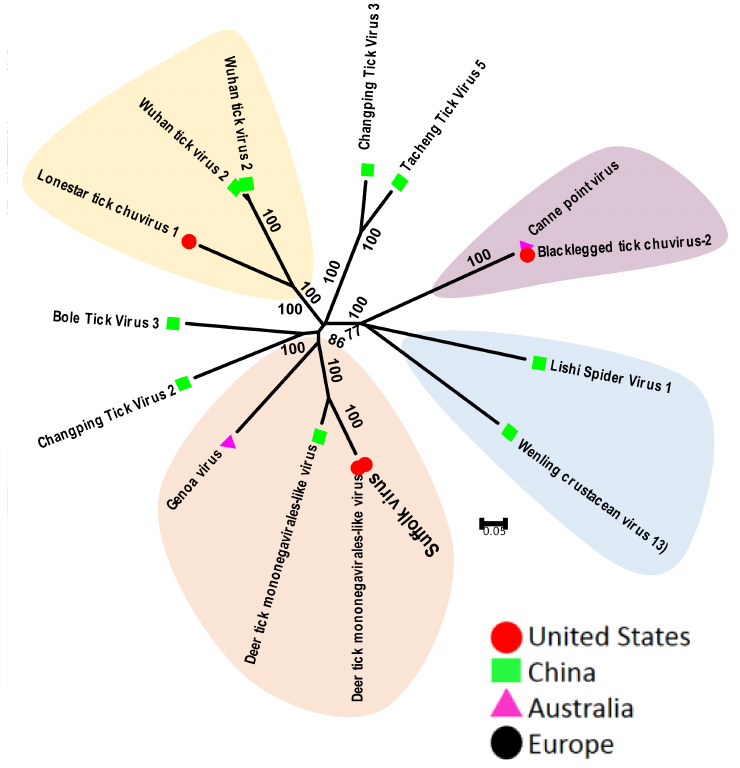
Figure 3. Phylogenetic relatedness between tick chuviruses. This analysis used 15 amino acid sequences of the viral polymerase gene. Genbank accession numbers of sequences used for phylogenetic analysis are: YP_009177218 Su ff olk virus, AIE42676 Deer tick mononegavirales-like virus, AXQ59273 Deer tick mononegavirales-like virus, AYP67566 Genoa virus, YP_009177704 Changping Tick Virus 2, YP_009177701 Bole Tick Virus 3, YP_009254000 Lonestar tick chuvirus 1, YP_009177707 Changping Tick Virus 3, YP_009177717 Tacheng Tick Virus 5, YP_009177722 Wuhan tick virus 2, AYV61060 Wuhan tick virus 2, AYP67535 Canne point virus, AJG39051 Lishi Spider Virus 1, AUW34382.1 L Black-legged tick chuvirus-2 and YP_009337860 Wenling crustacean virus